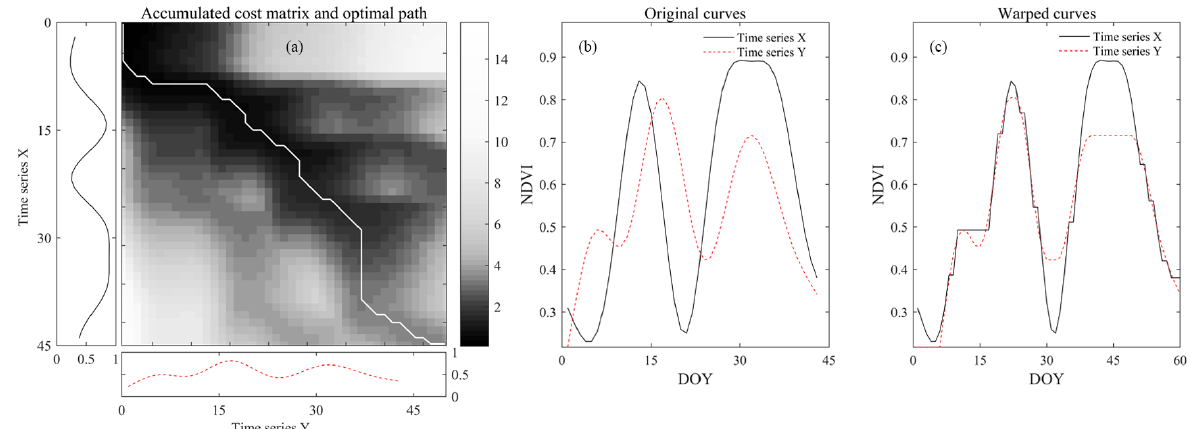
Figure 3. (a) Accumulated cost matrix and optimal warping path between two NDVI sequences and (b, c) original and warped time series, respectively. DOY: day of